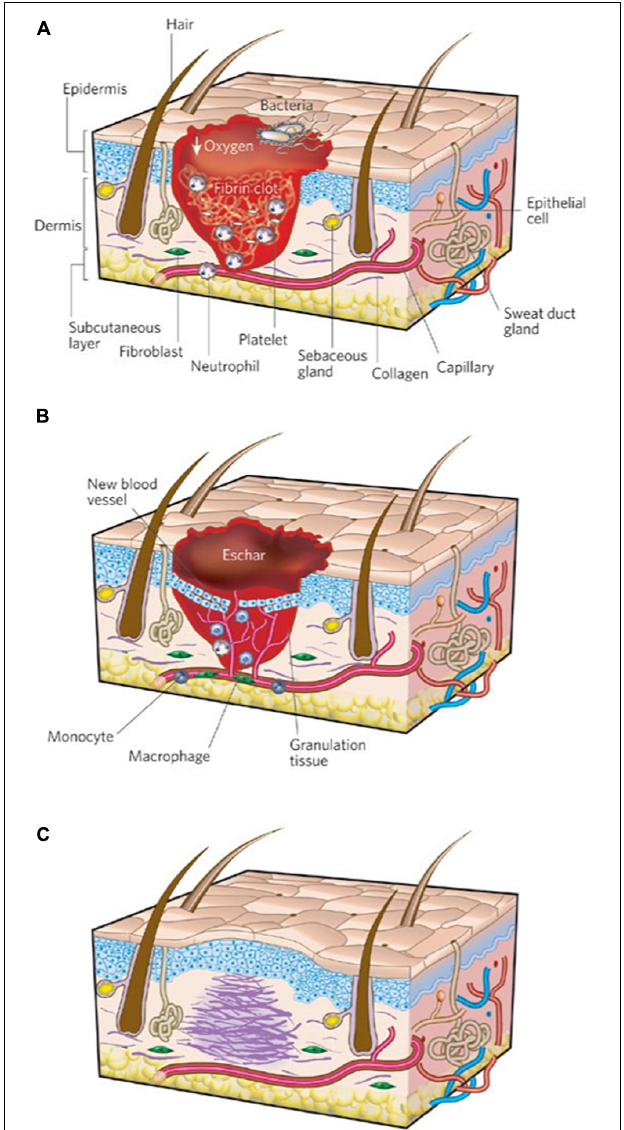
FIGURE 1 | Three stages of wound repair. The three phases of wound repair consist of (A) inflammation, (B) new tissue formation, and (C) remodeling. (A) The inflammatory phase lasts until about 48 h after injury. Depicted is a skin wound at about 24–48 h after injury. The wound is characterized by a hypoxic (ischemic) environment in which a fibrin clot has formed. Bacteria, neutrophils, and platelets are abundant in the wound. Normal skin appendages (such as hair follicles and sweat duct glands) are still present in the skin outside the wound. (B) New tissue formation occurs about 2–10 days after injury. Depicted is a skin wound at about 5–10 days after injury. The majority of cells from the previous stage of repair have migrated from the wound, and new blood vessels now populate the area. An eschar (scab) has formed on the surface of the wound, and the migration of epithelial cells can be observed under the eschar. (C) Remodeling lasts for a year or longer. Depicted is a skin wound about 1–12 months after repair. Disorganized collagen has been laid down by fibroblasts that have migrated into the wound and contracted the wound. The re-epithelialized wound is slightly higher than the surrounding surface, and the healed region does not contain normal skin appendages. Figure adapted with permission from Figure 1 of Gurtner et al.